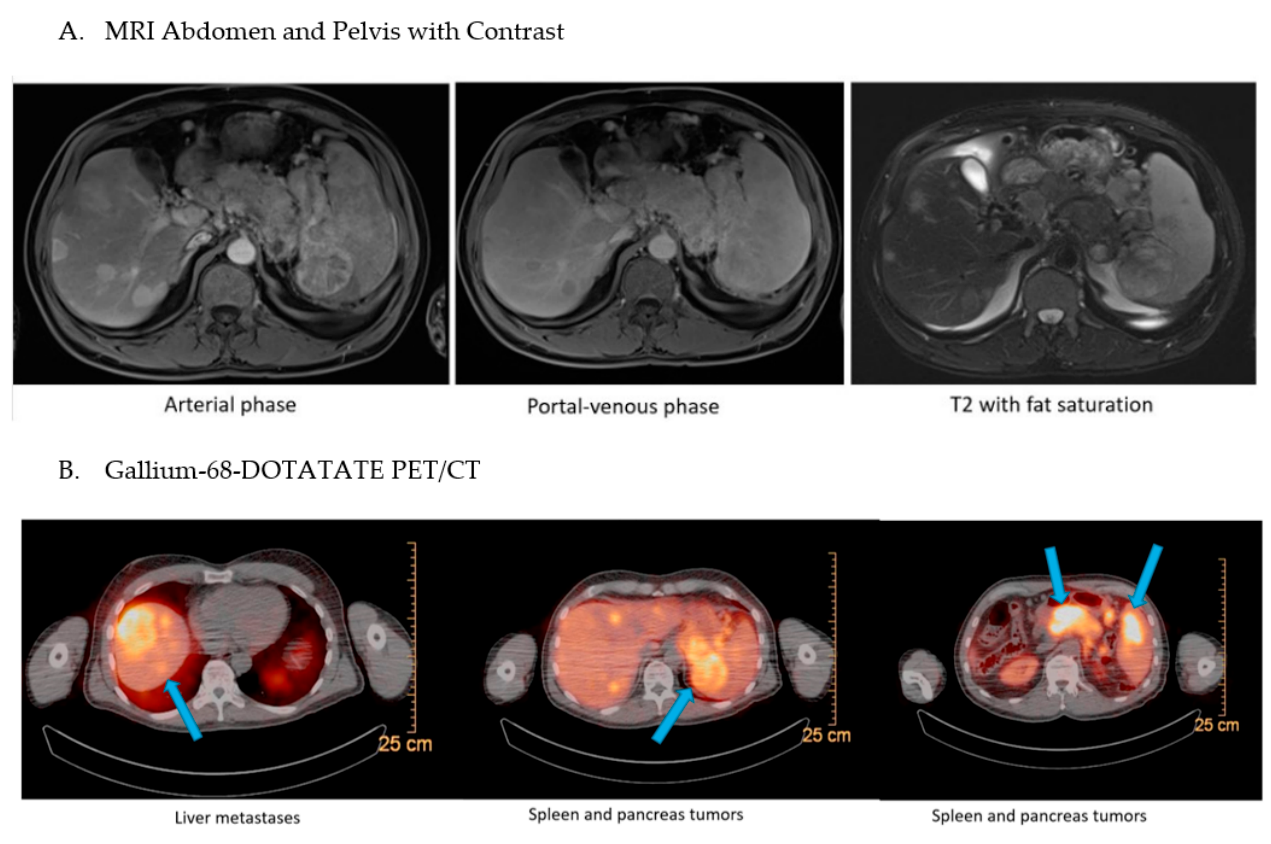
Figure 1. Imaging Studies of the Abdomen and Pelvis. ( A ) For diagnostic purposes, MRI was obtained using gadolinium contrast. Representative images of three phases are shown as indicated. ( B ) The patient was subjected to a Gallium-68-DOTATATE PET/CT and several areas of high-intensity uptake are delineated by arrows in the series of cross-sections.